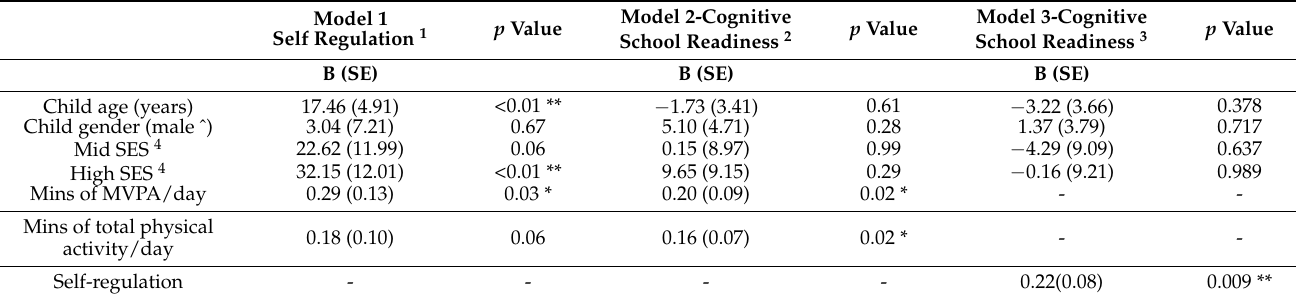
Table 2. Association between MVPA, total physical activity, self-regulation score and cognitive school